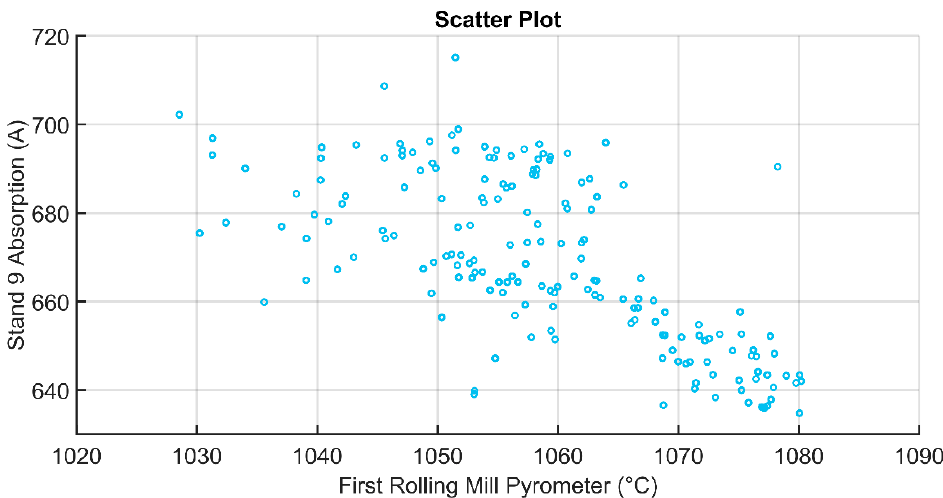
Figure 9. Scatter plot comparing the first rolling mill pyrometer and the absorption in stand 9.